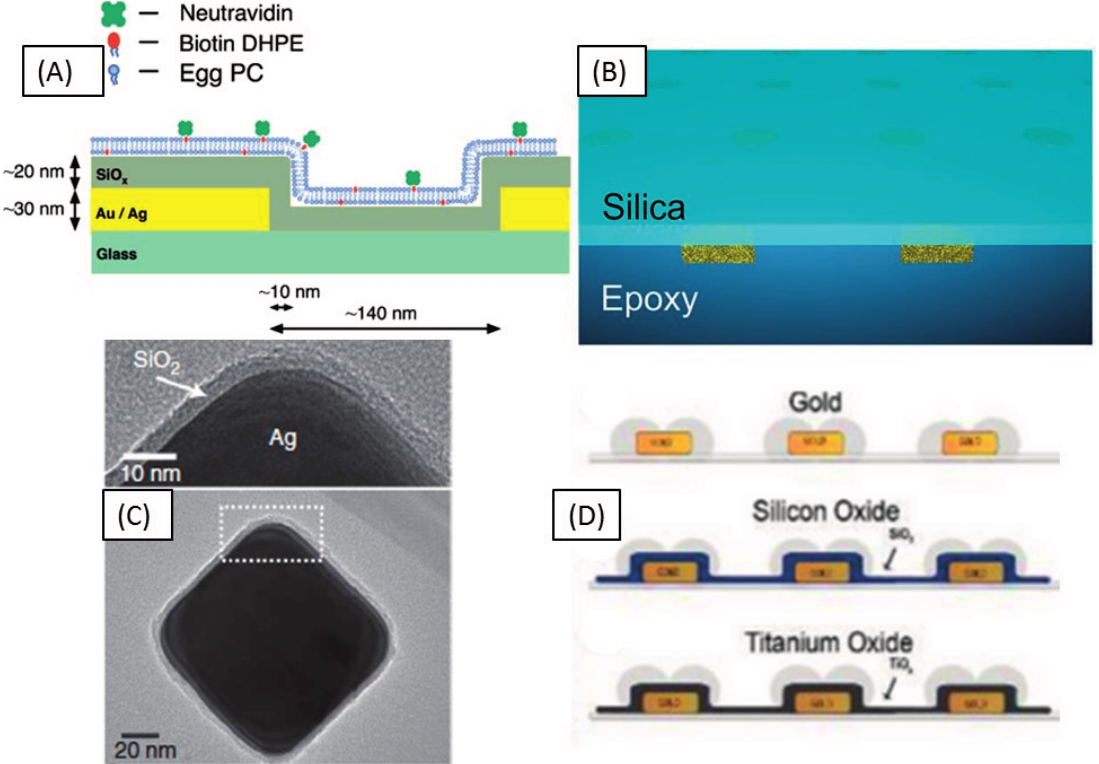
Figure 5. Current bilayer LSPR based sensing schemes employing silica